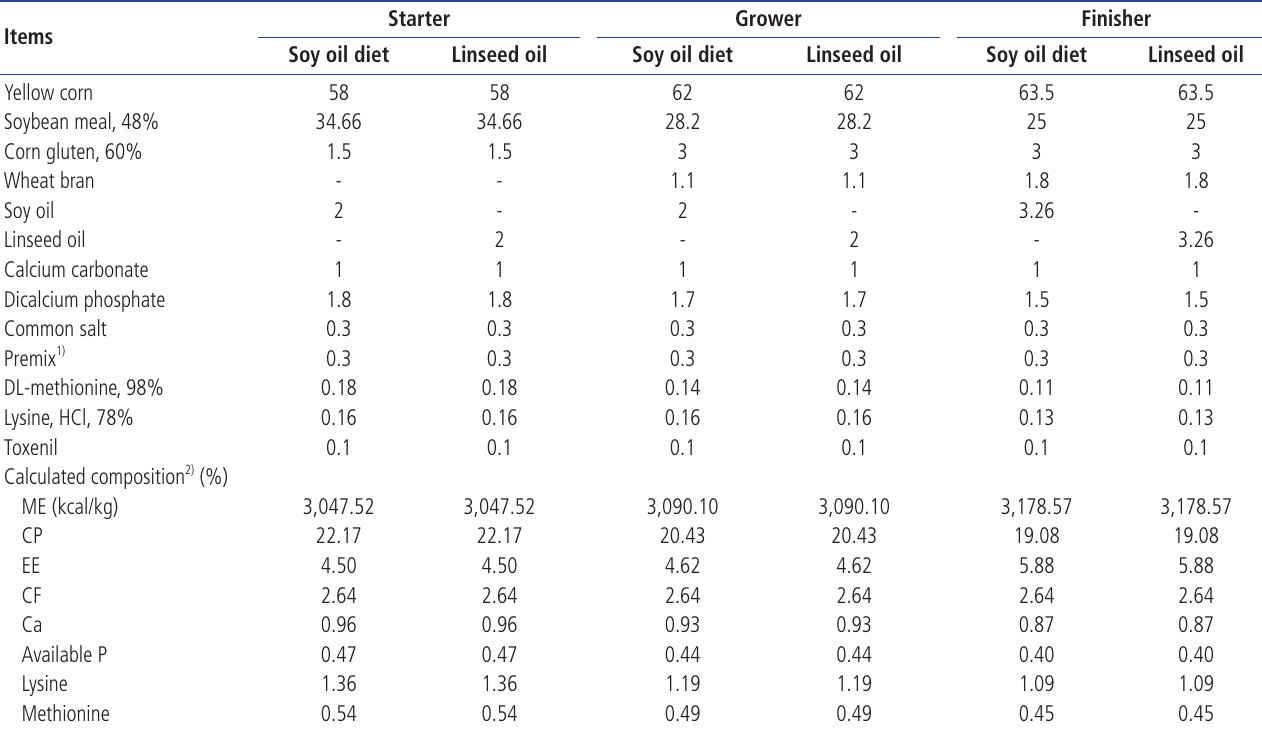
Table 1. Contents and chemical composition of the